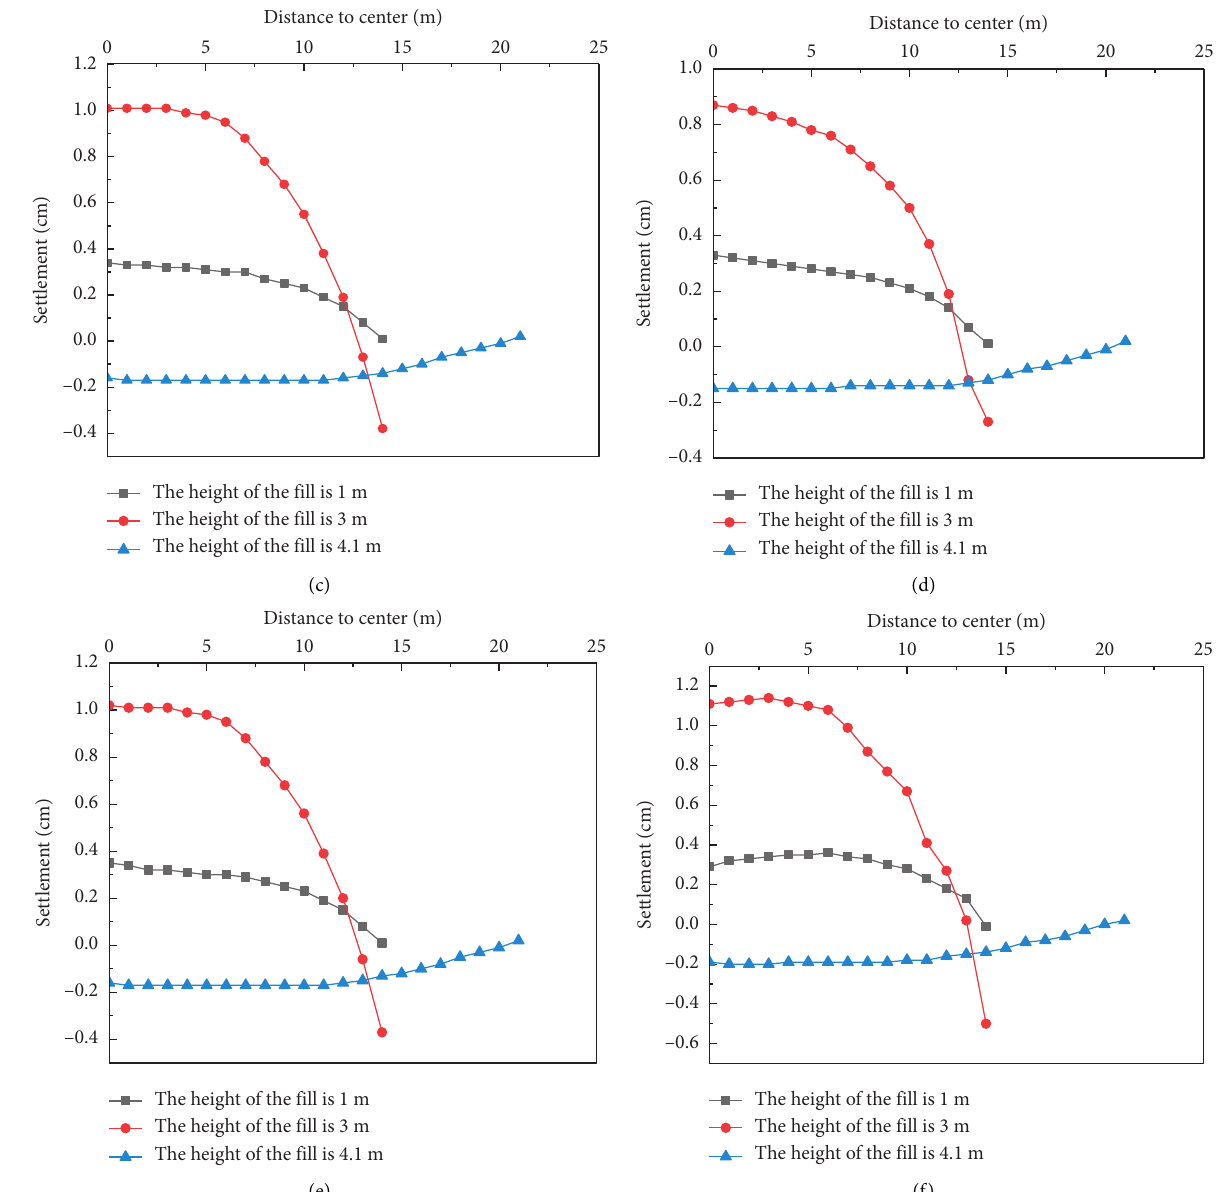
Figure 5: Layered settlement diagram of subgrade surface under different piles spacings. (a) Pile spacing under the slope of the existing road equal to 200% of the pile diameter. (b) Pile spacing under the slope of the existing road equal to 300% of the pile diameter. (c) Pile spacing under the slope of the existing road equal to 400% of the pile diameter. (d) Pile spacing under the existing subgrade and new embankment equal to 200% of the pile diameter. (e) Pile spacing under existing subgrade and new embankment equal to 300% of the pile diameter. (f) Pile spacing under existing subgrade and new embankment equal to 400% of the pile